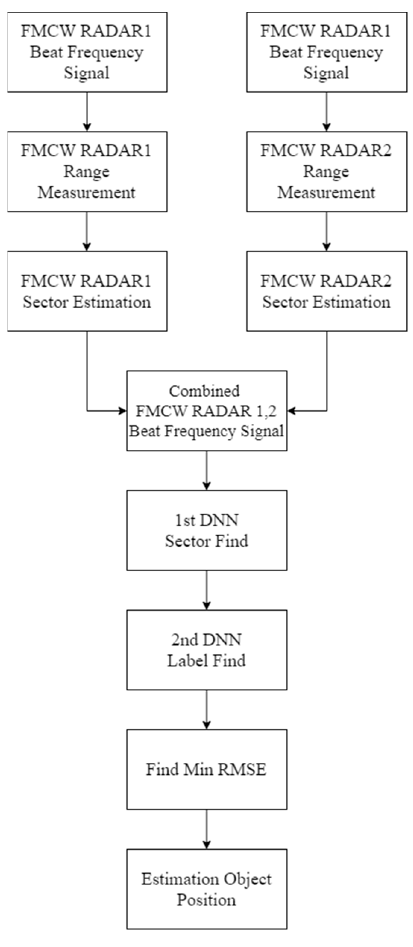
Figure 4. Algorithmic description diagram.